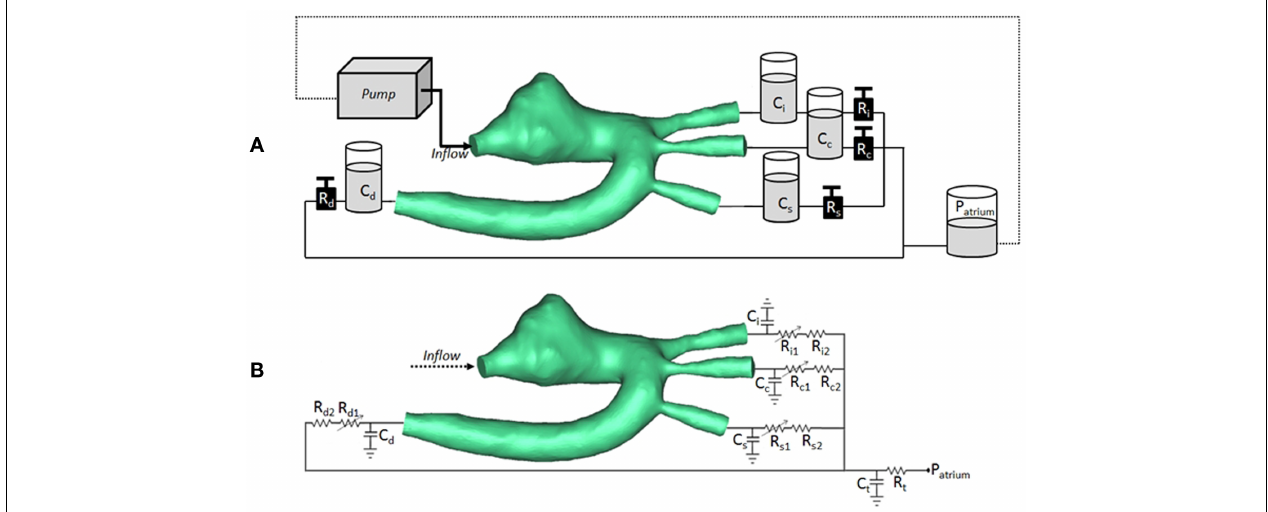
FIGURE 2 | (A) Arrangement of compliant (C) and resistive (R) elements in the in vitro setup, as air chambers and metered taps, respectively, also showing the 3D rapid-prototyped model (TGA patient in the picture), the pump, and the atrial chamber implementing atrial pressure ( P atrium ). (B) Arrangement for corresponding multi-scale CFD simulation, including 3D volume of TGA patient, coupled with lumped parameter network summarizing the remainder of the system. Each outlet is simulated with a non-linear and linear resistor in series. C i / R i = compliance/resistance for innominate artery; C c / R c = compliance/resistance for carotid artery; C s / R s = compliance/resistance for subclavian artery; C d / R d = compliance/resistance for descending aorta; C t / R t = terminal compliance/resistance; P atrium = atrial